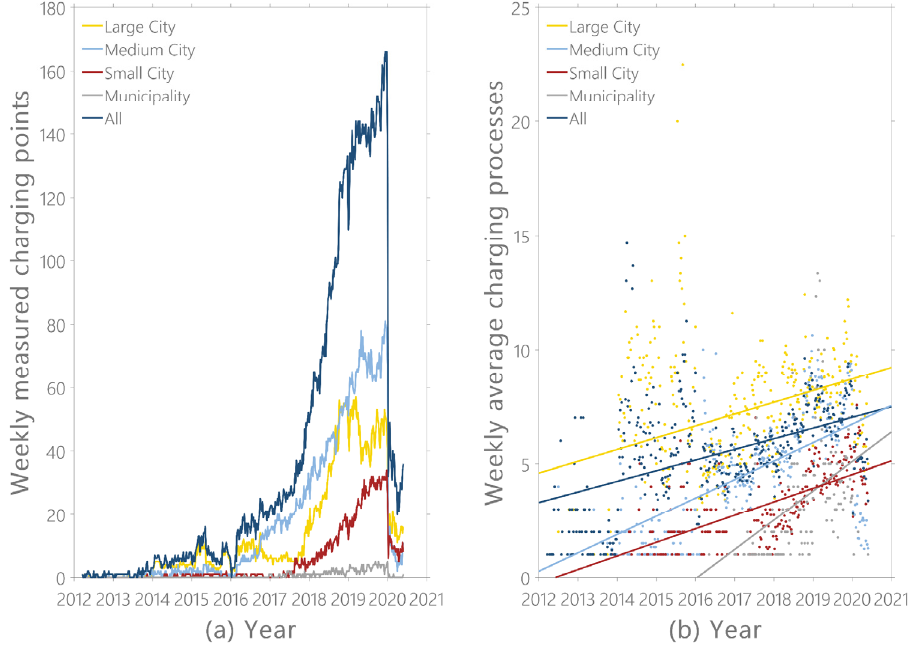
Figure 5. Weekly measured CPs ( a ) and average weekly charging processes performed there including least squares trend line ( b ) over the measurement recording period.